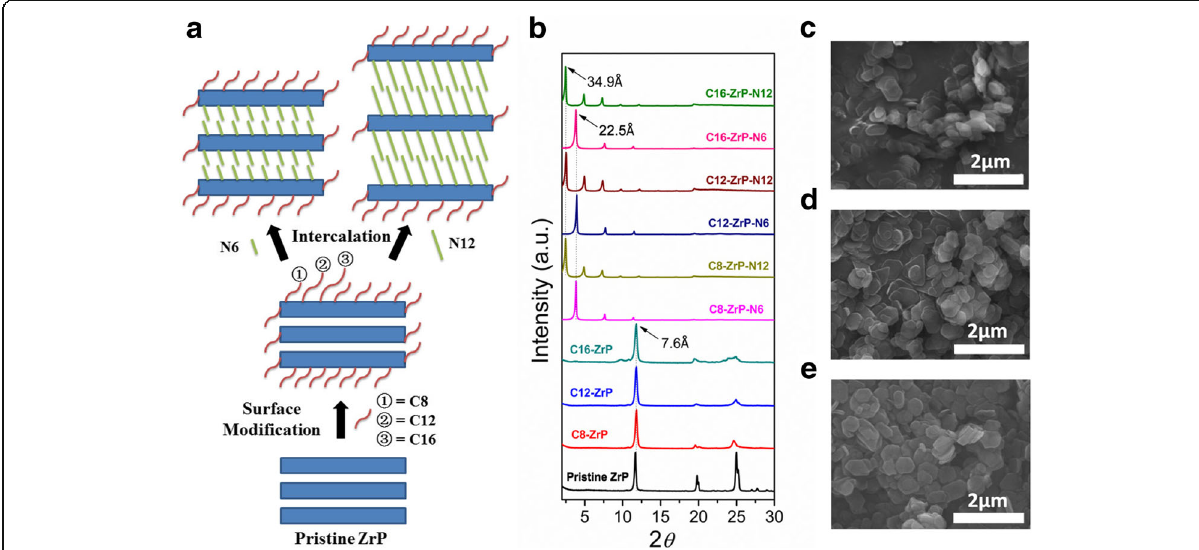
Fig. 2 Surface and interlayer modifications of ZrP nanoplatelets: a schematic illustration of sample preparations. b XRD patterns. SEM images of c pristine, d surface-modified, and e surface-modified and intercalated ZrP